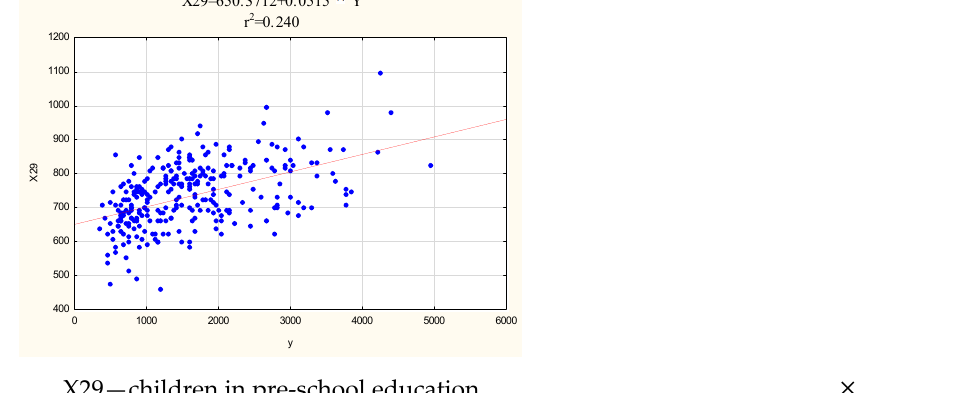
Figure 11. Relationship between the model of vulnerability to epidemic risks (KLE(pop)) and 11 accepted variables. Source: own study.